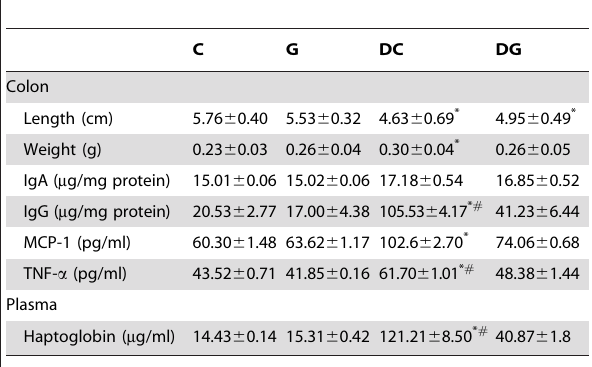
Total RNA was isolated from MLNs using the Trizol reagent (Invitrogen, Carlsbad, CA). RNA (1 m g) was reverse-transcribed using random hexamer primers with a complementary (c)DNA synthesis kit (Fermentas, Glen Burnie, MD) according to standard